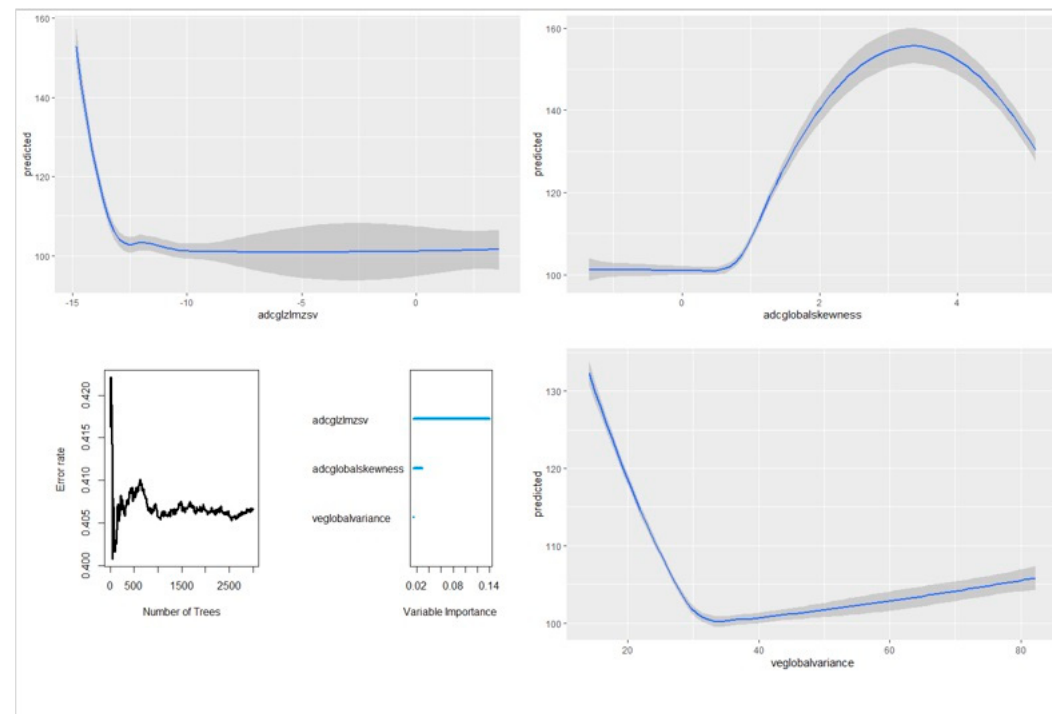
Figure 3. Relative importance of the radiomics features included in the study (Left), and the minimal depth of the variables in the random forest model (right).